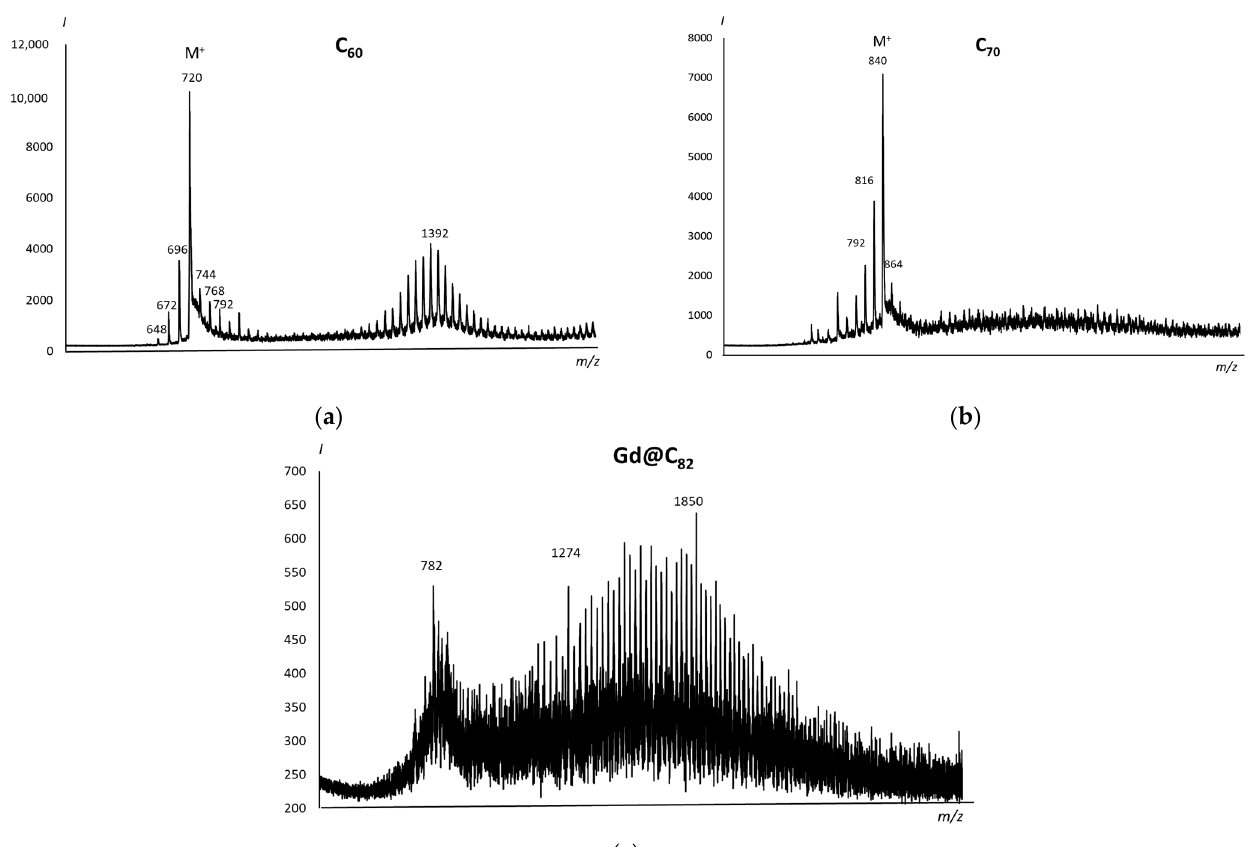
Figure 1. MALDI positive-ion mass spectra of AFDs of ( a ) C60, ( b ) (C70), and ( c ) Gd@C82 in an α -cyano-4-hydroxycinnamic acid matrix.